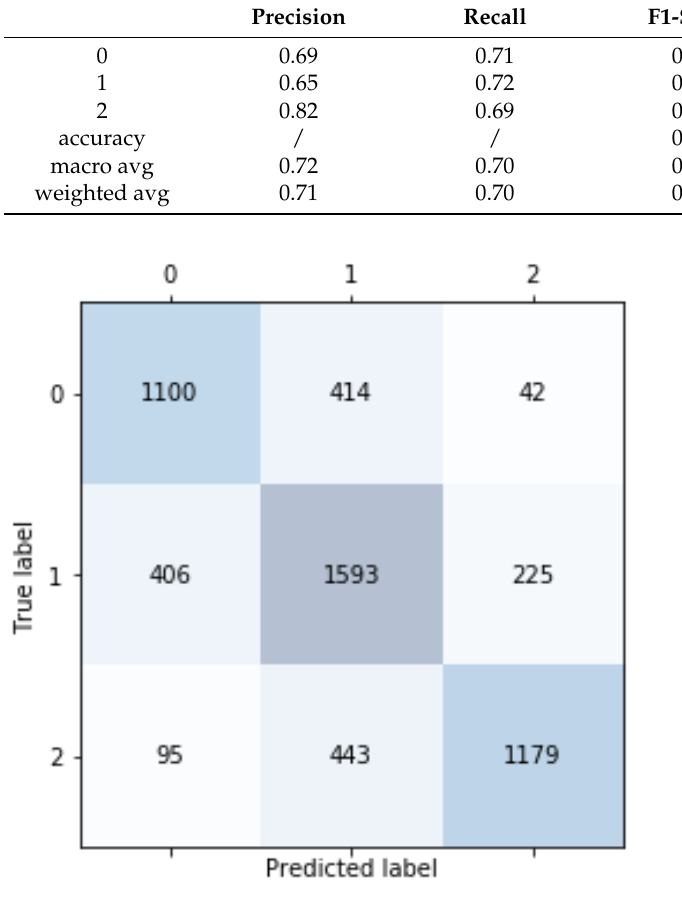
Figure 7. Confusion matrix for CNN-LSTM sentiment analysis.